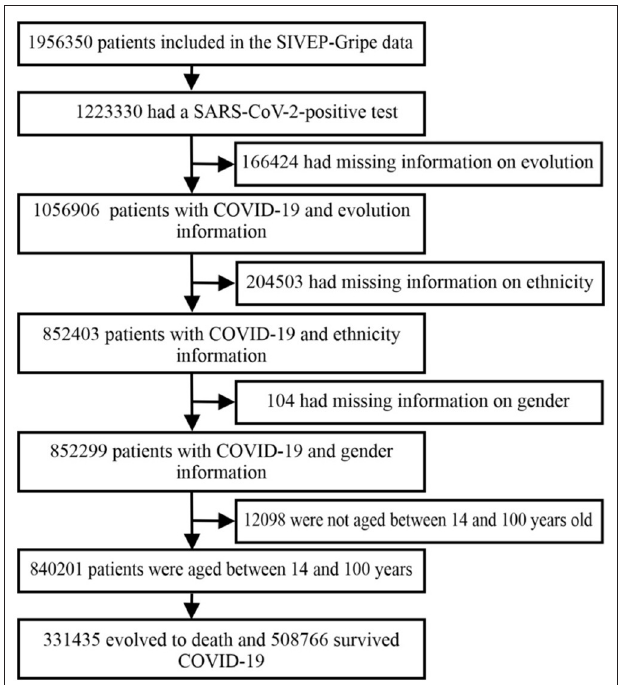
FIGURE 1 | Flowchart of the SIVEP-Gripe database used in this analysis. SARS-CoV-2, severe acute respiratory syndrome coronavirus 2; SIVEP-Gripe, Influenza Epidemiological Surveillance Information